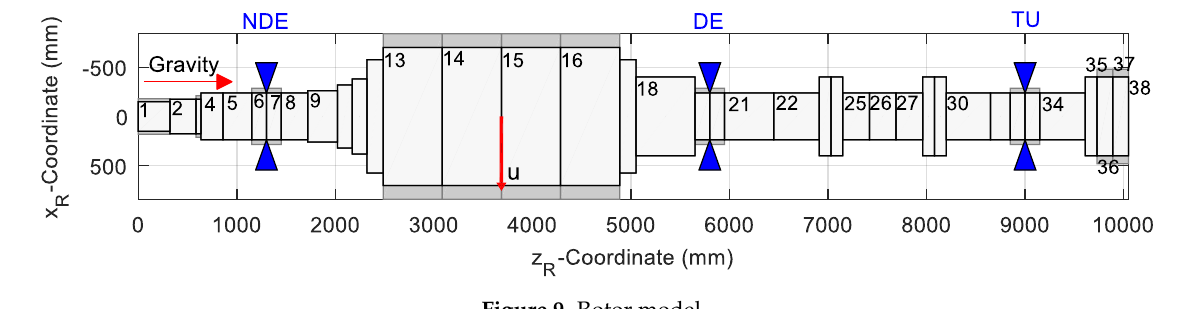
Figure 9. Rotor model.